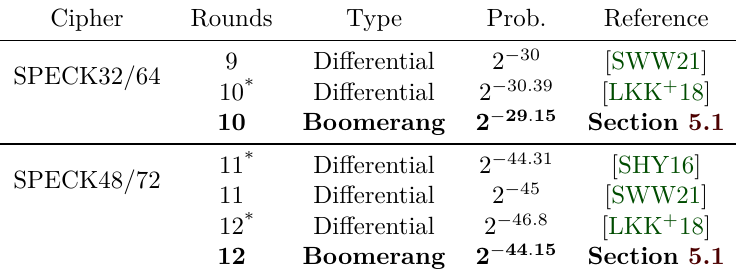
Table 1: Comparison of our distinguishers with previous